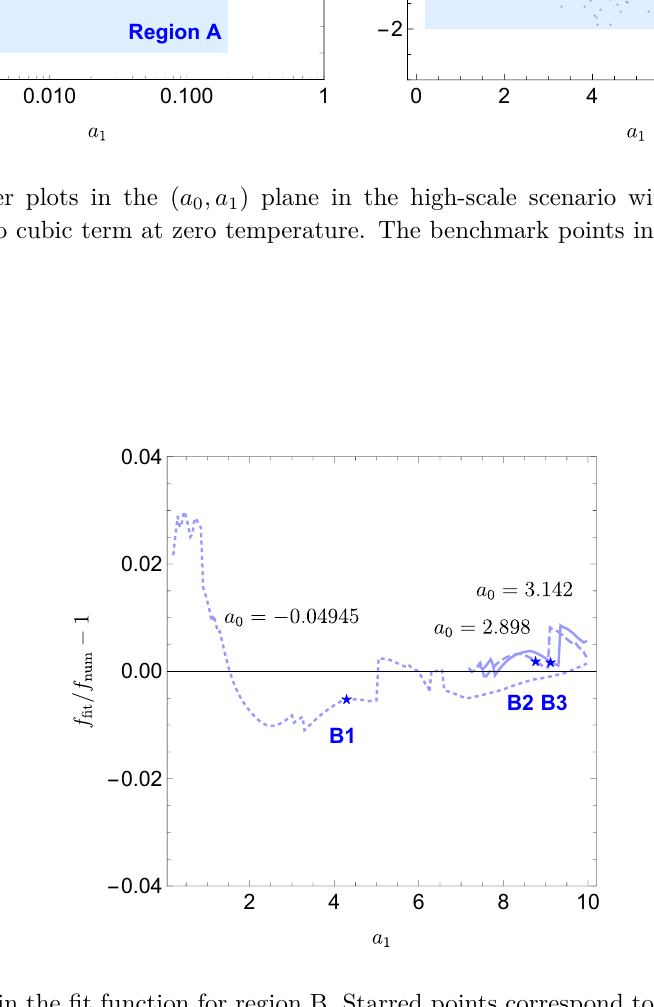
Figure 8 . Errors in the fit function for region B. Starred points correspond to values of a 0 for the benchmark points in table